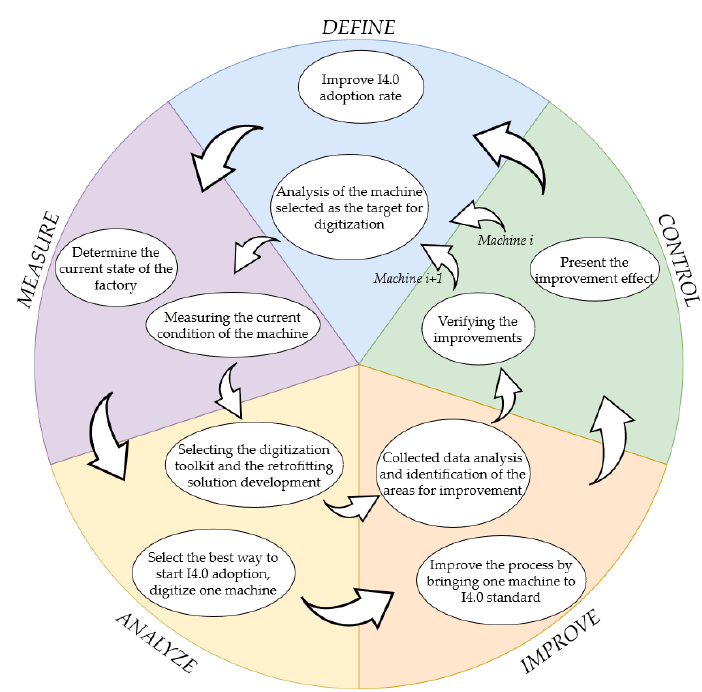
Figure 1. Industry 4.0 adoption process with the specific machine digitization